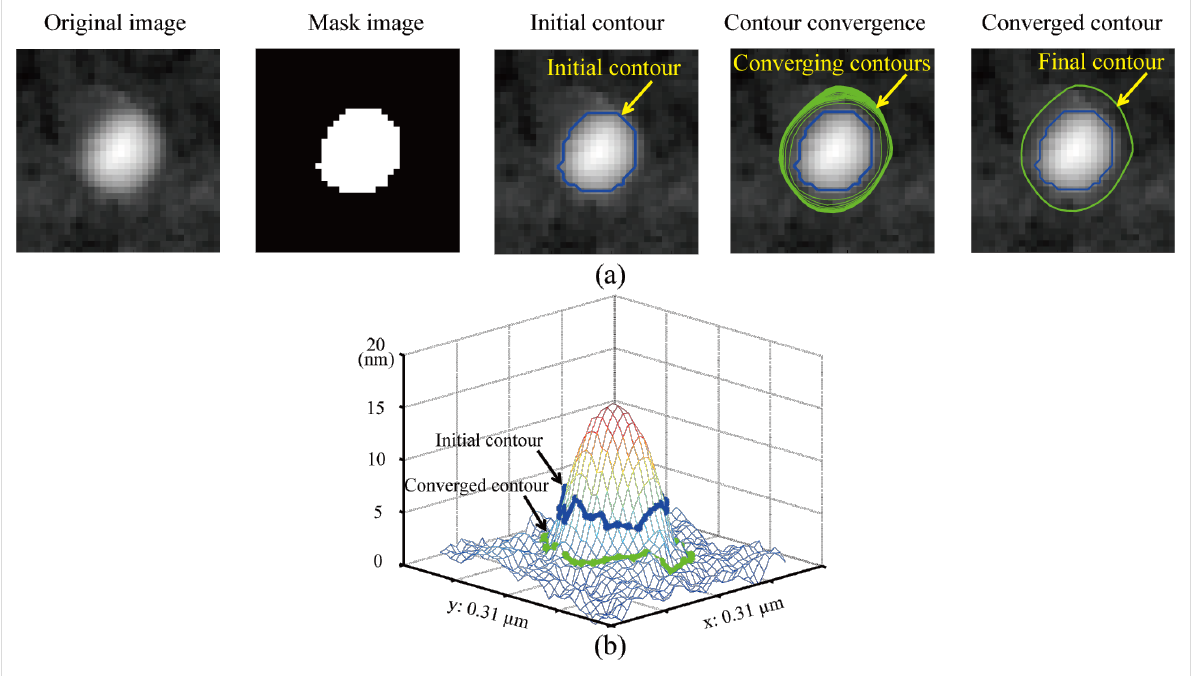
Figure 6: Demonstration of NB image segmentation with the proposed method. (a) The procedure of the NB boundary detection. The first figure shows the raw AFM image. The threshold method is used to select a preliminary mask for the selected NB, as shown in the second figure. The boundary of the mask obtained in the threshold method is extracted and taken as the initial contour (third figure). Driven by the field of gradient of height, the initial contours gradually converge to the boundary, as indicated by the green contours in the fourth figure. The contour is finally converged at the boundary, where the contour achieves the minimum energy (fifth figure). (b) Mesh plot of the NB with the detected boundaries obtained by the threshold method and the proposed method. It is clear that the proposed method provides an optimized boundary detection with a correct detected area as compared with that obtained with the threshold